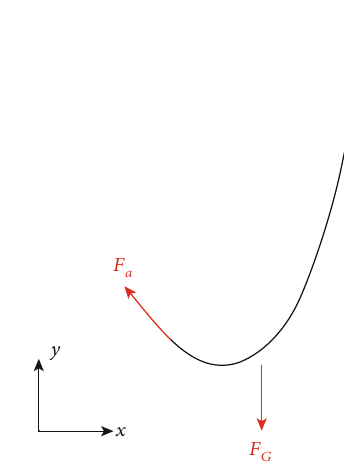
F a and b are the